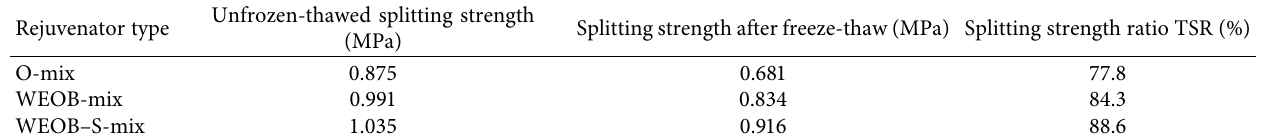
Table 9: Freeze-thaw splitting test results of rejuvenated asphalt